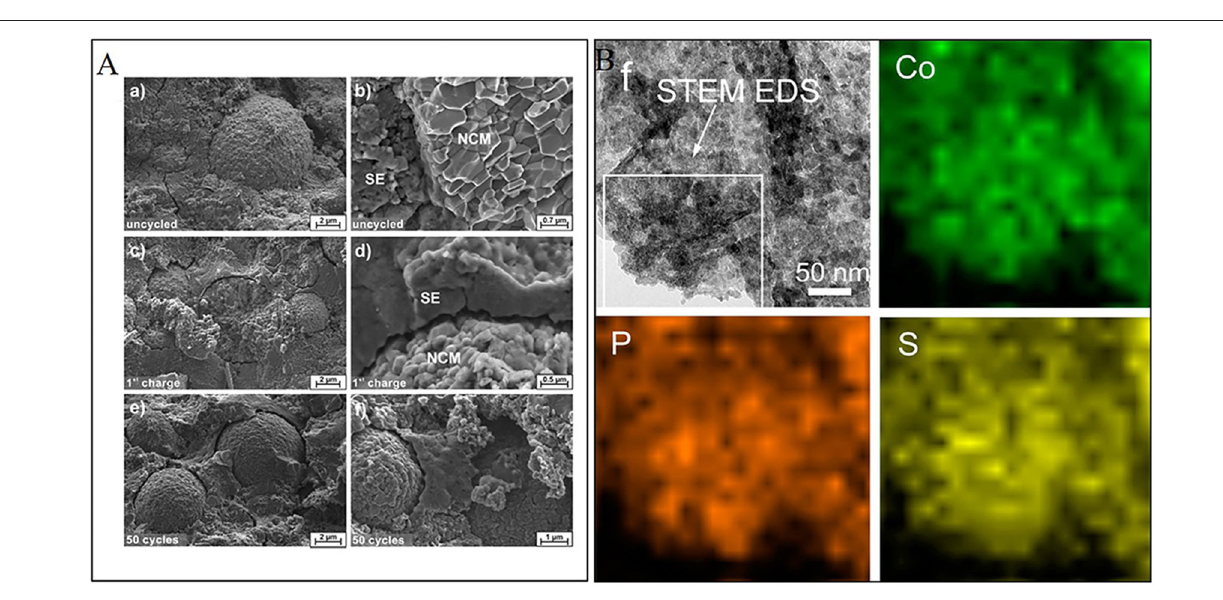
FIGURE 6 | (A) Scanning electron micrographs of the cathode composite of NCM811 and β -Li 3 PS 4 : (a,b) before cycled; (c,d) after single charging to 4.3V vs. Li/Li + at 0.1C; (e,f) after 50 full battery cycles in the discharged state. [Reprinted with permission from (Koerver et al., 2017). Copyright (2017) American Chemical Society]. (B) STEM EDS elemental mapping images of cobalt sulfide-Li 7 P 3 S 11 nanocomposites. [Reprinted with permission from (Yao et al., 2016). Copyright (2016) American Chemical